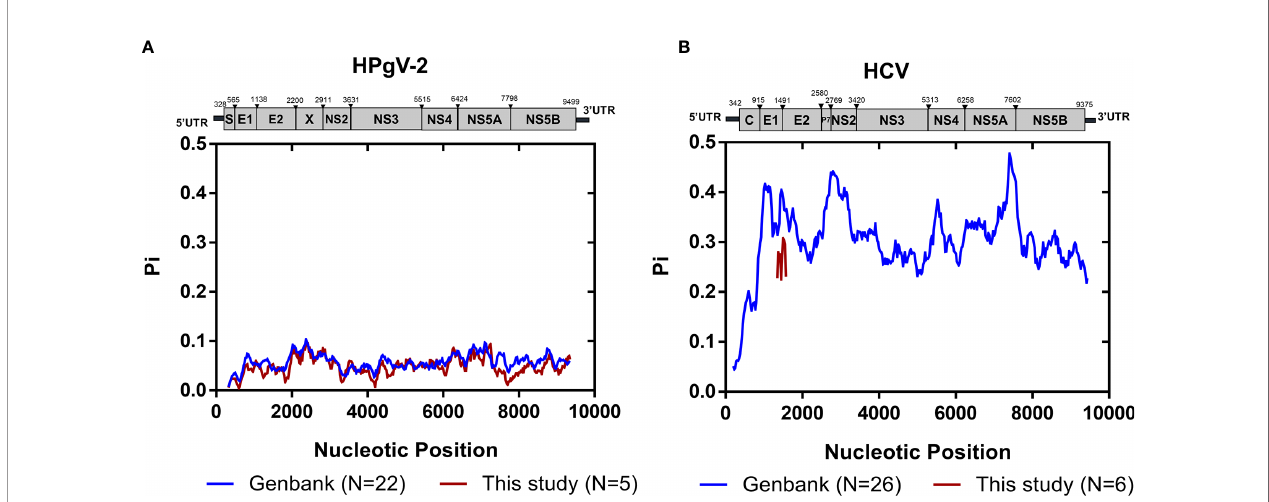
FIGURE 2 | Genomic polymorphism of HPgV-2 and HCV. (A) Genomic polymorphism among 22 strains of HPgV-2 obtained from the GenBank database and fi ve HPgV-2 consensus sequences of this study are respectively shown. The nucleotide positions are numbered according to the human pegivirus 2 isolate UC0125 (GenBank accession number KT427414). (B) Genomic polymorphism among 26 strains of HCV obtained from the GenBank database and six HCV HVR1 consensus sequences of this study are respectively shown. The nucleotide positions are numbered according to HCV strain H77 (GenBank accession number NC_004102). Graph was constructed using sliding window of 200 nucleotides and steps of 25 nucleotides.